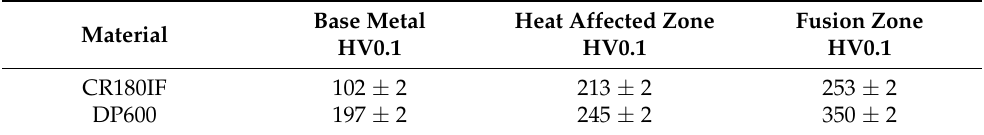
Table 3. Measured values of microhardness